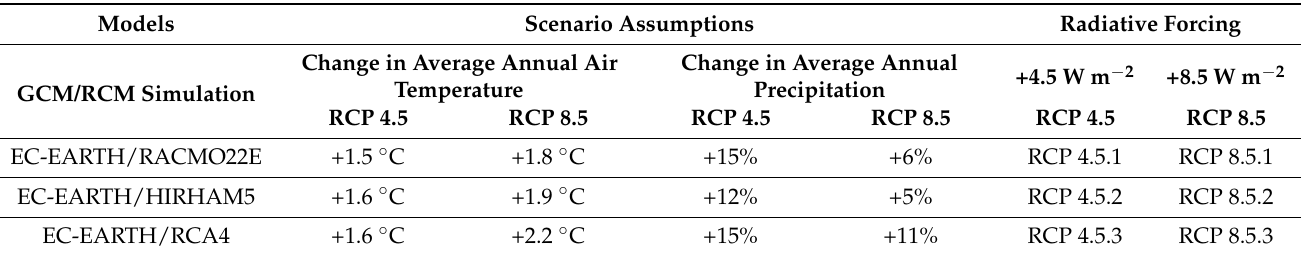
Table 3. Description of GCM/RCM simulation with its division depending on radiative forcing. Comparison of temperature and precipitation changes in 2021–2050 in GCM/RCM simulation for RCP 4.5 and RCP 8.5 to the base period 1971–2000 (own